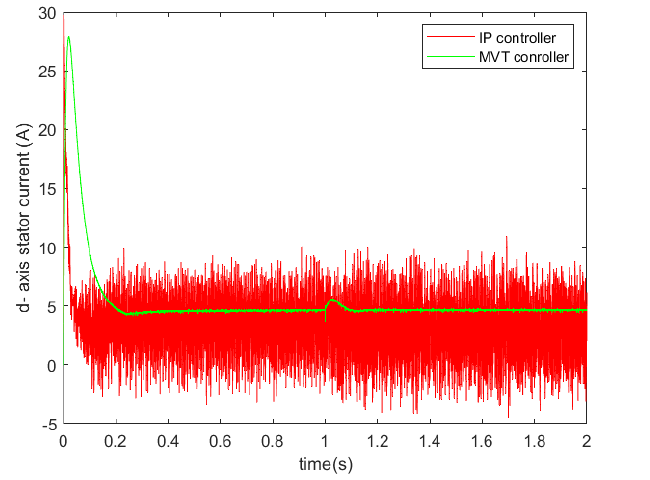
Figure 6. d-axis current waveform under two controllers.